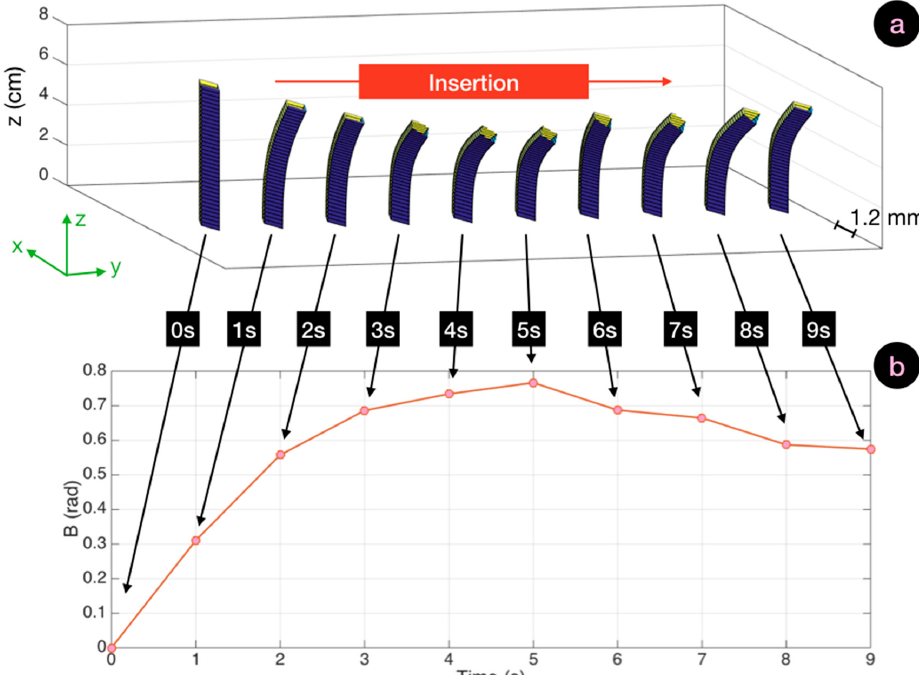
Figure 8. Bending cinematic for an insertion with reduced bending, and the corresponding SBPA chart. ( a ) Cinematic of a straight insertion (9 s duration), displaying the reconstructed silhouette of the needle (1.2 mm cross-section on xy , 8 cm length along z ) through the whole insertion. ( b ) Corresponding SBPA chart showing the value of B corresponding to each bending